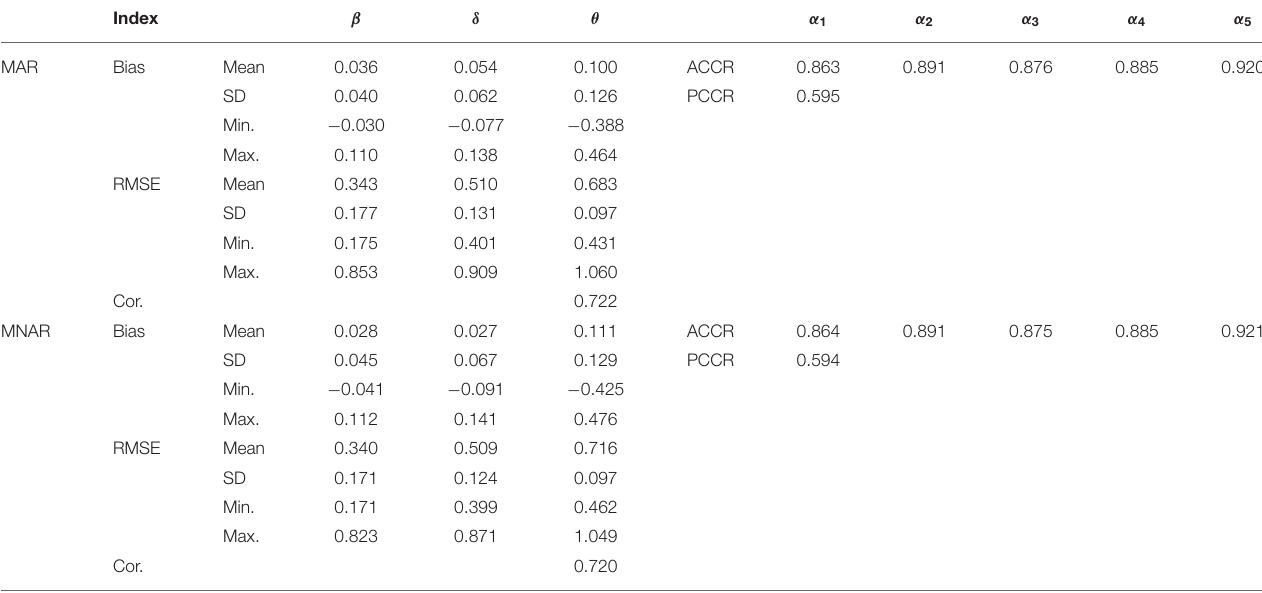
TABLE 4 | Summary of the item parameter, general ability, and attributes.